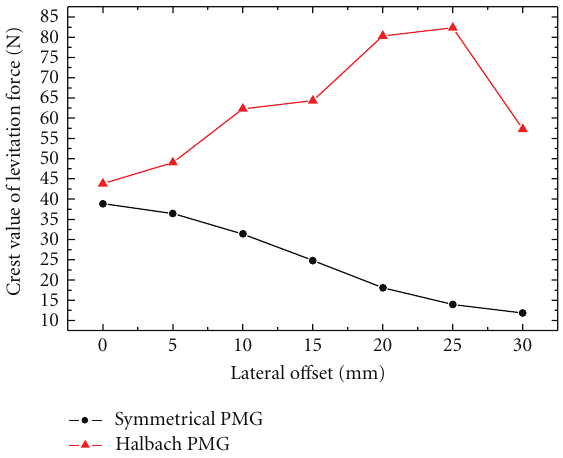
Figure 6: Maximum levitation forces of bulk HTS above two types PMG with di ff erent lateral o ff sets.